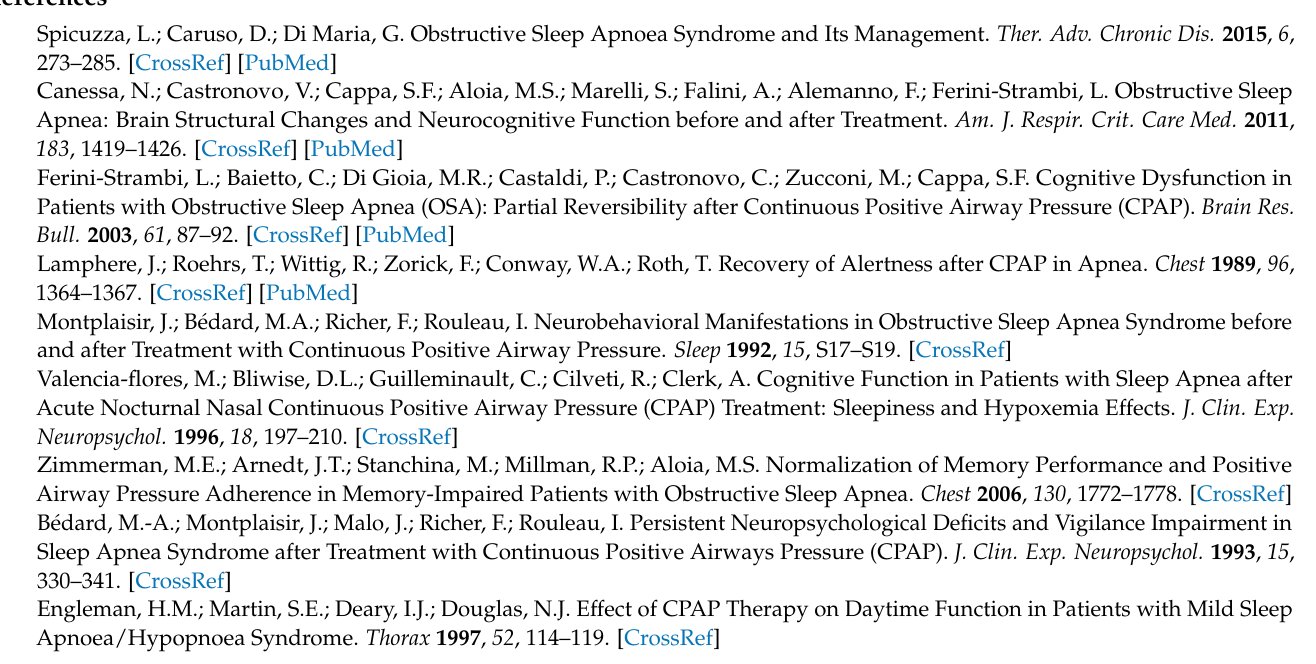
Table S4: Results of the hierarchical multiple linear regression analysis investigating the possible predictors of the accuracy of strategic reasoning, problem-solving, and mental planning (i.e., Tower of London—Accuracy